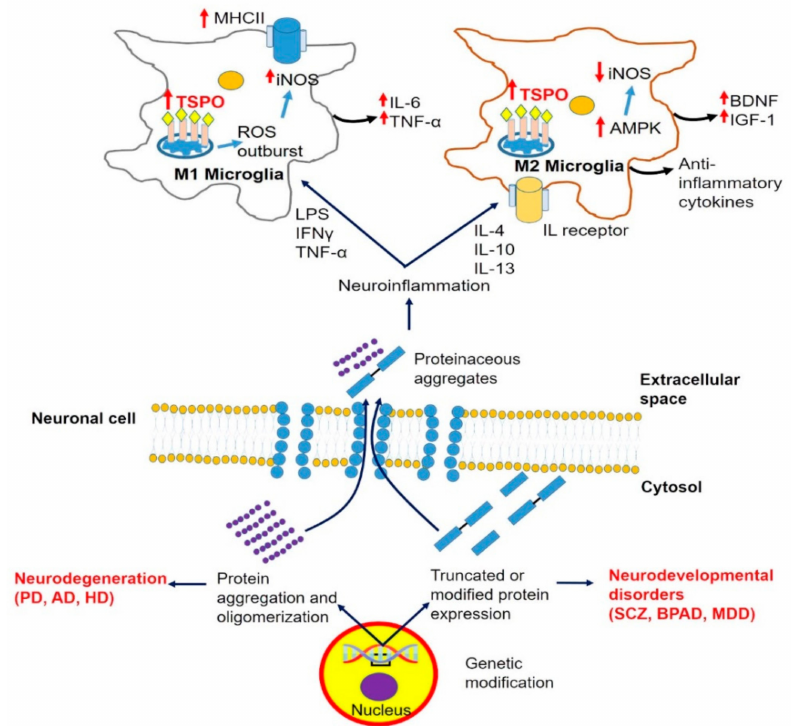
Figure 3. Cellular pathology of neurodegenerative and neurodevelopmental diseases and its correlation with microglial response and modulation of TSPO ligand-binding potentials. Neurodegeneration initiatedbycellularproteinmodificationoraggregationinducesaninflammatoryresponse,